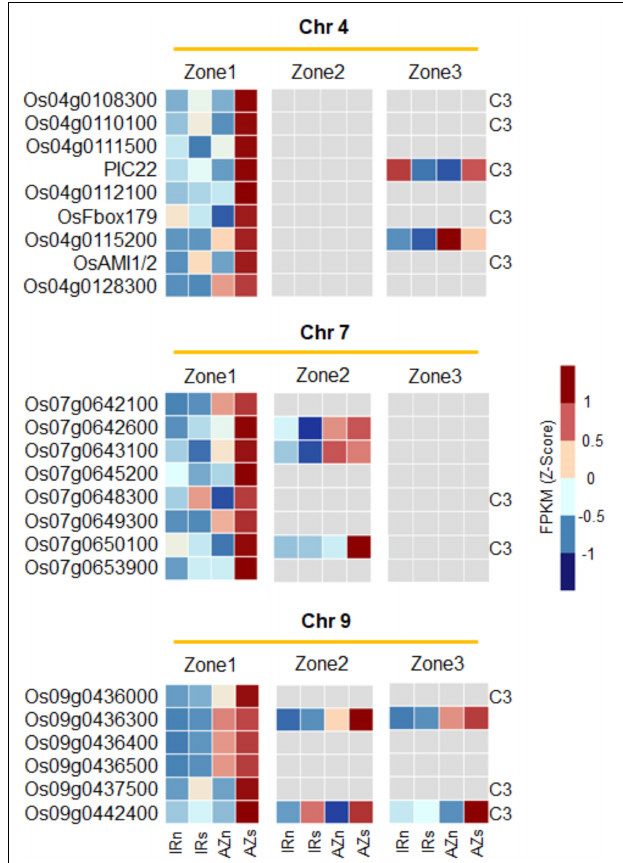
FIGURE 9 | The expression pattern of the co-expressed regions on chromosome 4, 7, and 9 across all three root zones revealing they are zone 1-specific. Three subsets of genes on chromosomes 4, 7 and 9 co-upregulated in zone 1 of Azucena in response to water stress, and their expression pattern in Zones 2 and 3. Gray color depicts no significant change under stress. The genes co-localized with cluster 3 in the Figure 4A (highly upregulated DEGs in Z1 of Azucena) were labeled as C3. IRn, IR64 under normal condition; IRs, IR64 under stress condition; AZn, Azucena under normal condition; AZs, Azucena under stress